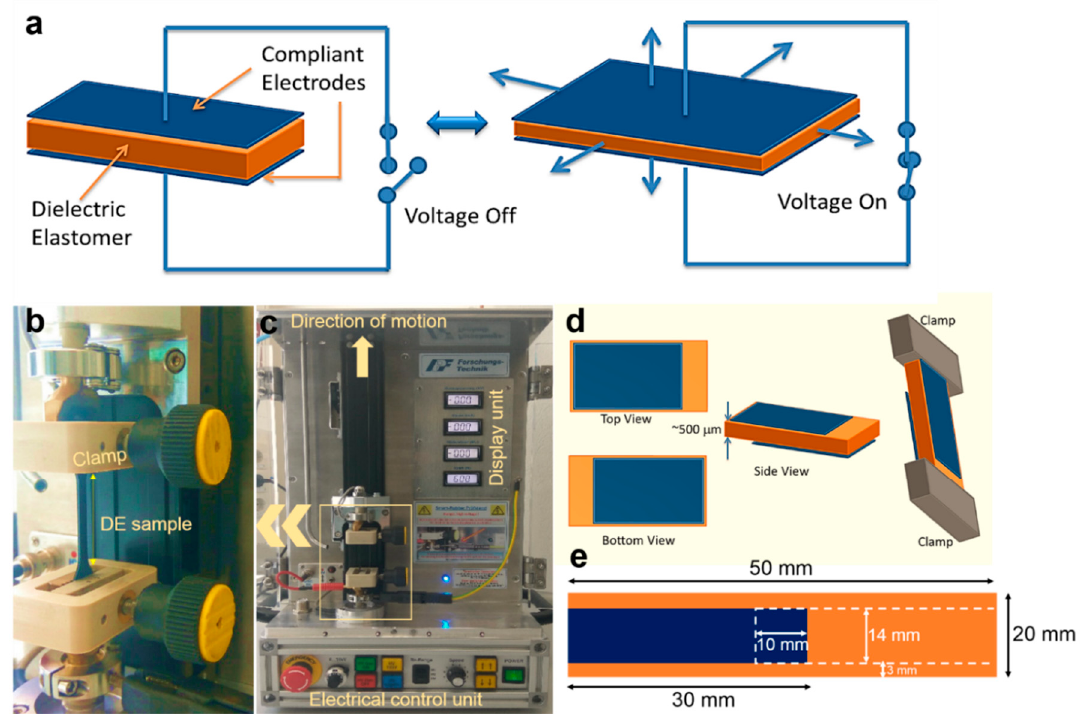
Figure 1. ( a ) Schematic representation of dielectric elastomer (DE) actuation upon application of an electrostatic force during voltage off and on state, respectively; ( b,c ) photographs of the Dresden Smart Rubber Analyzer (DRSA) with different units labeled. ( d ) Views of the fabricated electrodes from different viewing angle, and ( e ) dimension of the designed DE specimen (bottom).